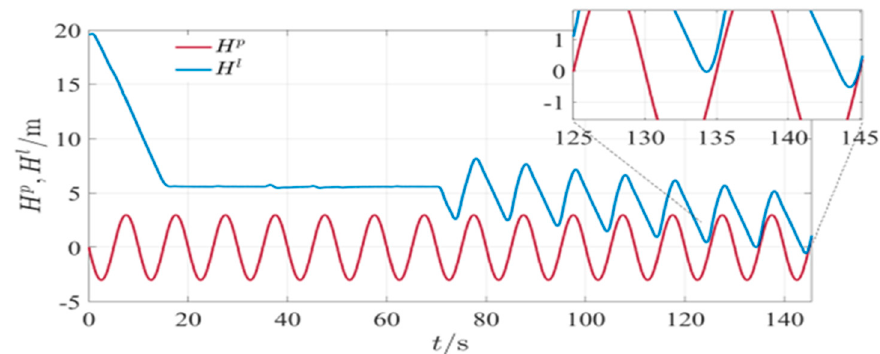
A m T s = = . Figure 49. The evolution of p H and l H vs. time when 6 , 10 Figure 49. The evolution of H p and H l vs. time when A w = 6 m, T w = 10 s. w w The motion speed of the helicopter relative to the platform at the contact moment Table 3. Relative velocities at the contact moment. − v veh is denoted as v pv , v pv = v p . When v pv is positive, the helicopter tends to move D D towards the platform. When v pv is negative, the helicopter tends to move away from the platform. The values of v pv at the contact moment corresponding to different wave heights and periods are listed as Table 3. Table 3. Relative velocities at the contact moment. A w /m